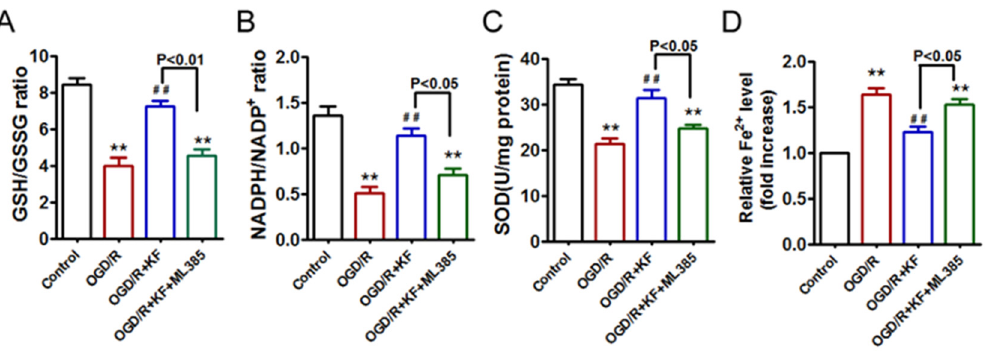
Figure 3. Effects of kaempferol on endogenous antioxidants and intracellular iron content in OGD/R-treated neurons. Neurons were treated as indicated in (Figure 1A). GSH/GSSG ratio ( A ), NADPH/NADP+ ratio ( B ), SOD activity ( C ), and intracellular iron content ( D ) were tested by ELISA. Three independent experiments were performed with similar results. ** p < 0.01 versus control; ## p < 0.01 versus OGD/R.